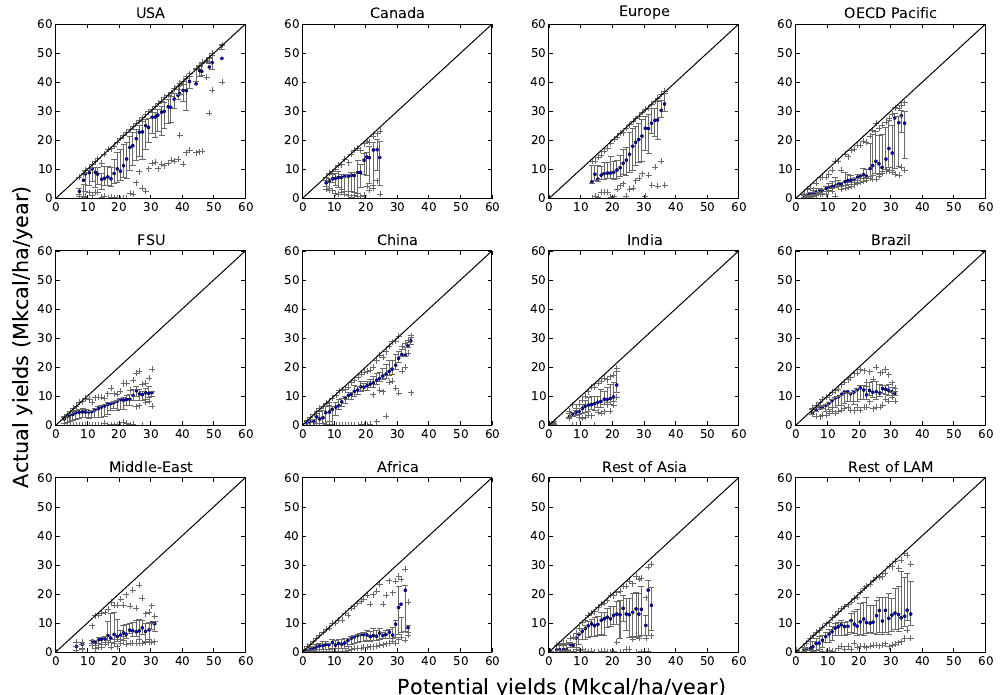
Fig. 9. Actual yield versus potential yield of dynamic crops within each potential yield class. Crosses are minimums and maximums, whiskers go from the 20th to the 80th percentile. X-axis in GJha − 1 yr − 1 ranges from 0 to 251. See Fig. 6 for a map of the difference between potential and actual yields of dynamic crops.